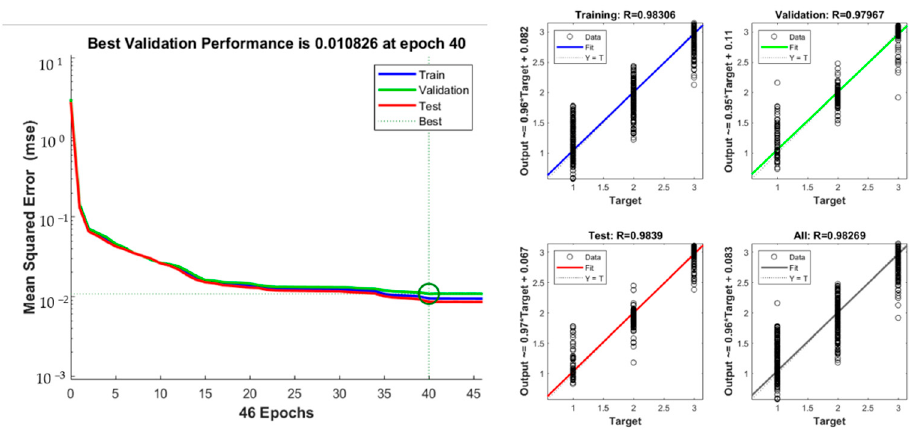
Figure 6. Training performance and regression plots. The flowchart in Figure 7 represents the algorithm used in the proposed model.